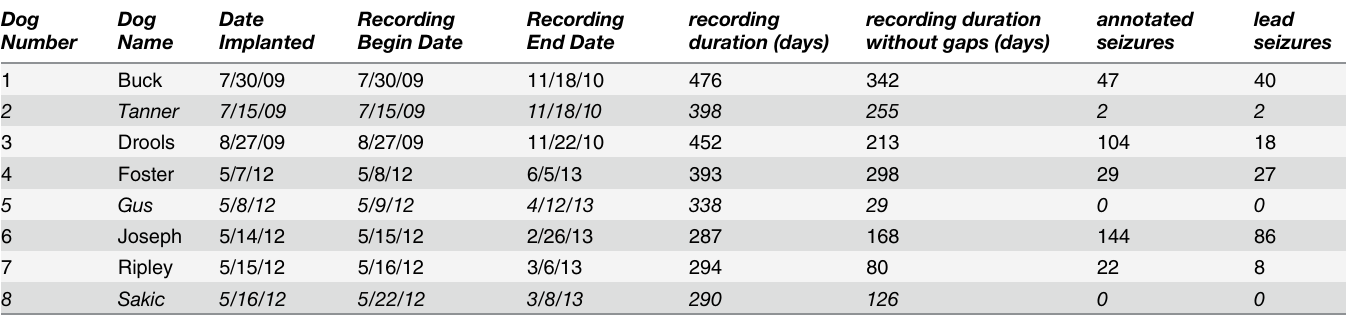
Table 1. Testing data.